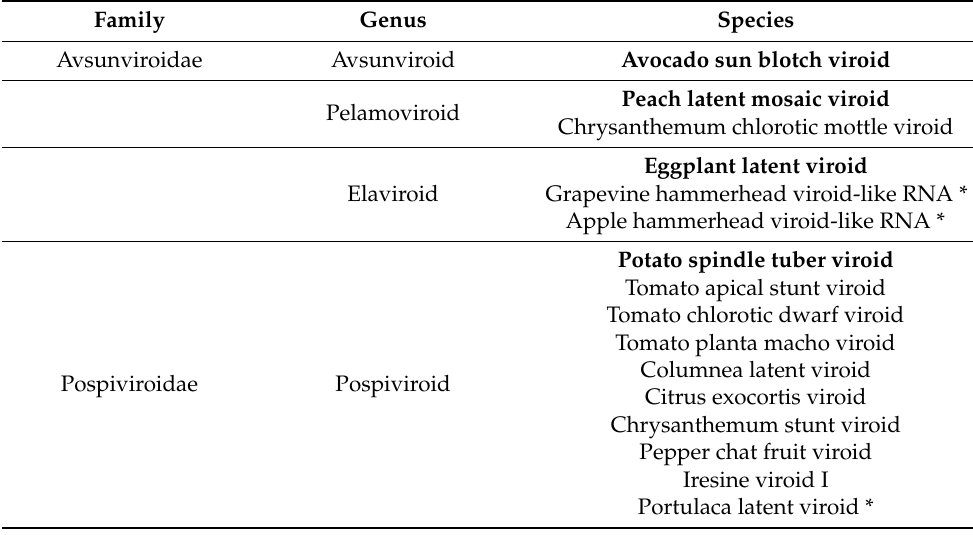
Table 2. Classification of viroids and viroid-like RNAs. Type member of each genus is indicated in bold. Viroid and viroid-like RNAs unassigned are represented by * symbol. (Adapted from Adkar-Purushothama and Perreault, 2019